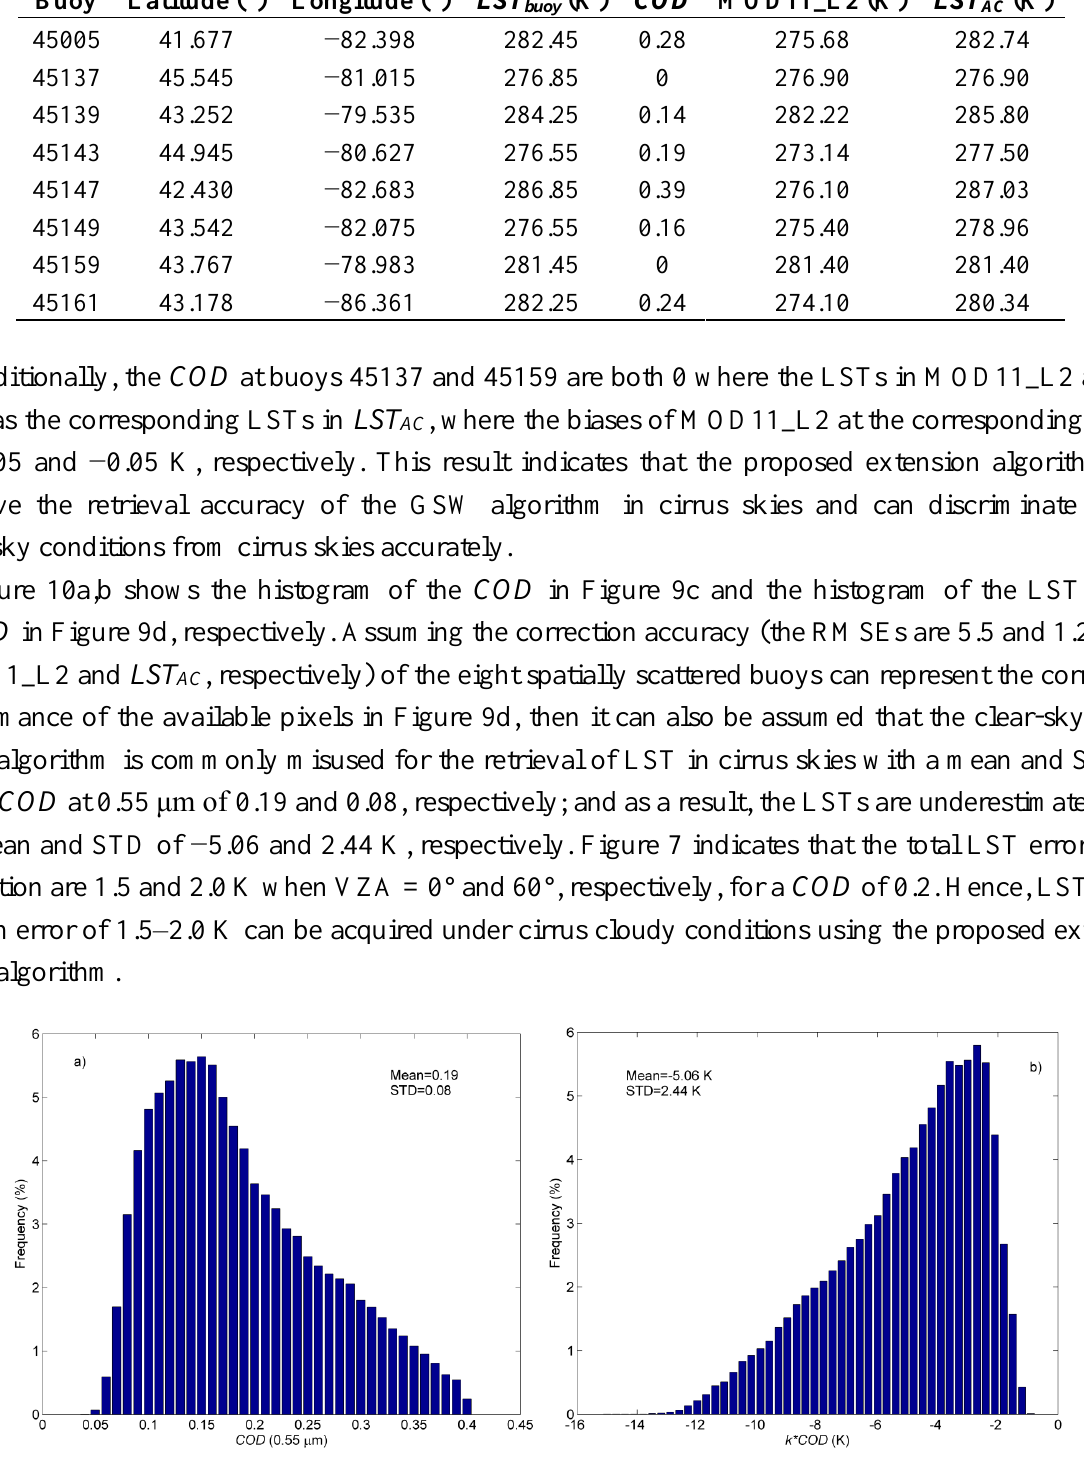
Figure 10. Histograms of ( a ) COD at 0.55 μm in Figure 9c and ( b ) LST errors estimated using the proposed extension algorithm ( k * COD ) in Figure